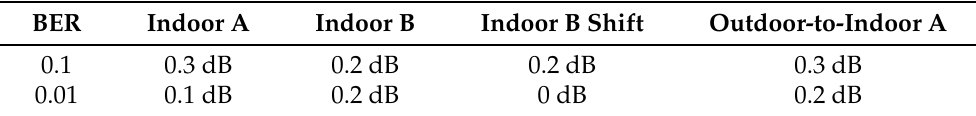
Figure 7. MSE and BER measures for outdoor-to-indoor A channel model. Table 4. SNR gap between N and G methods ( SNR N − SNR G ) for the particular BERs and channel models with a resolution 0.1 dB.